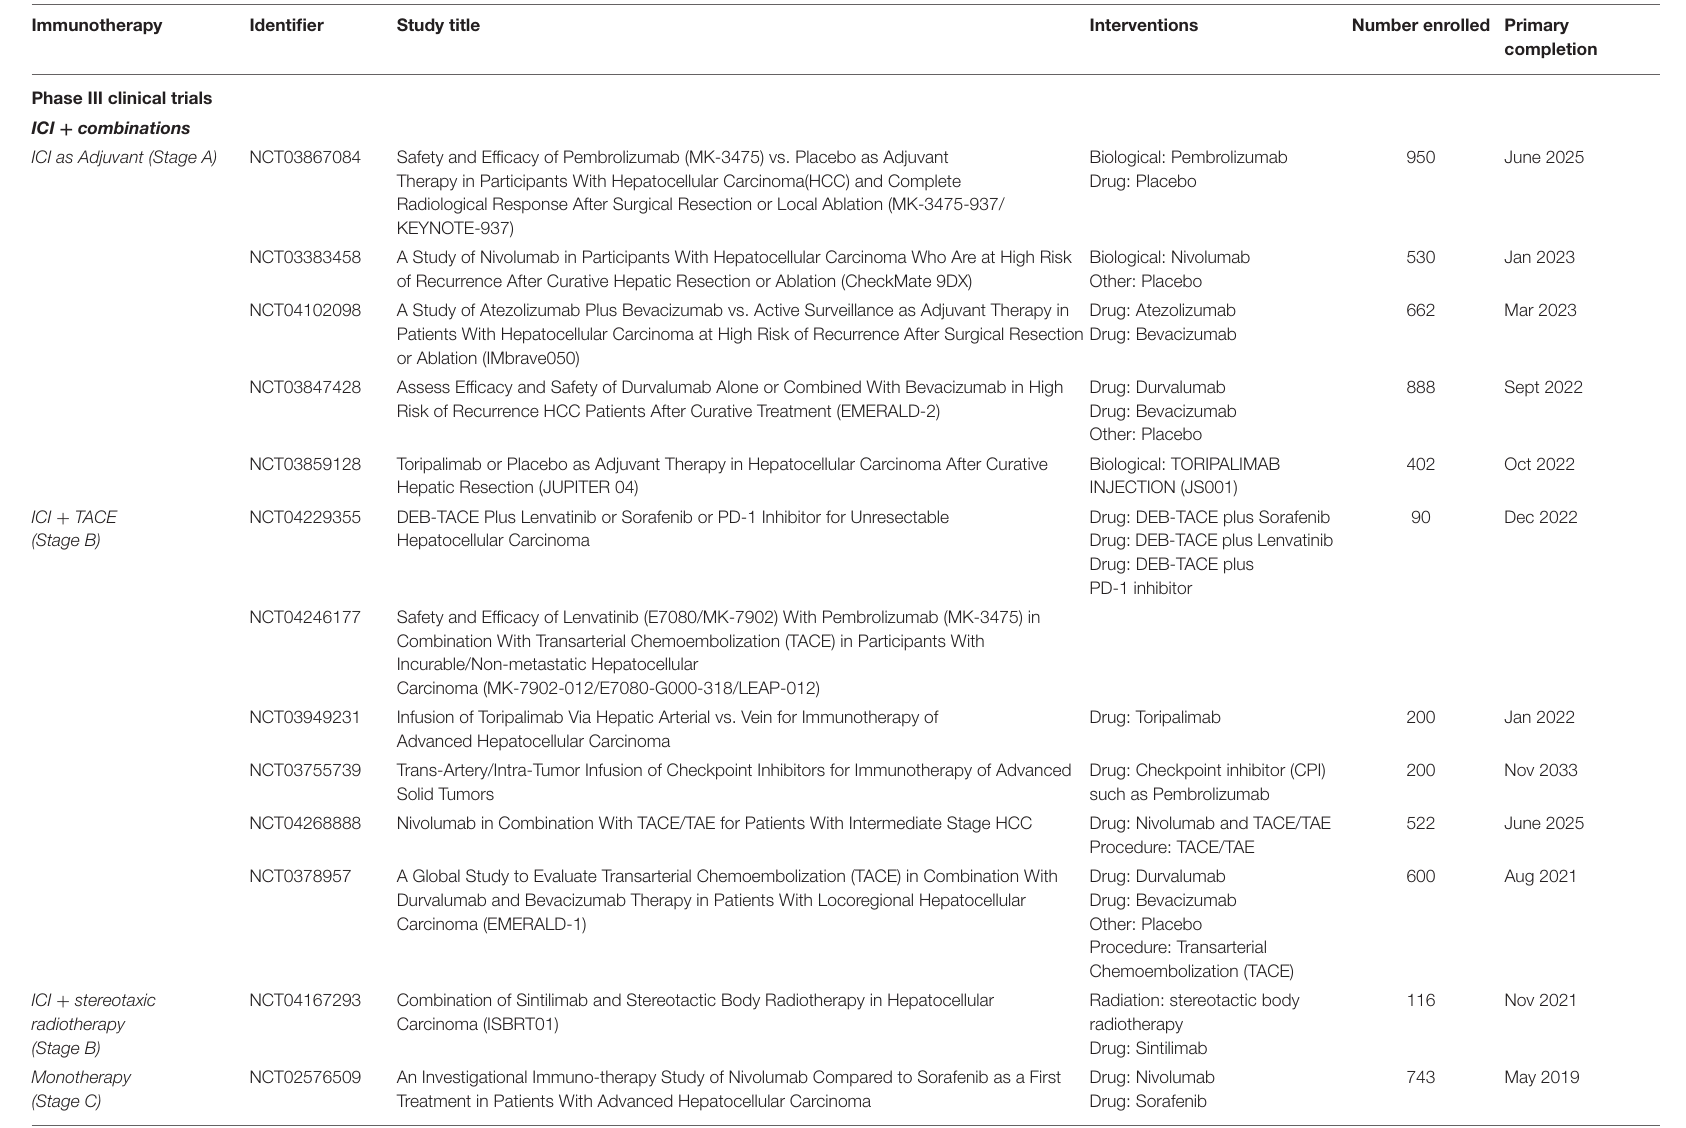
TABLE 1 | Clinical trials of immunotherapies for